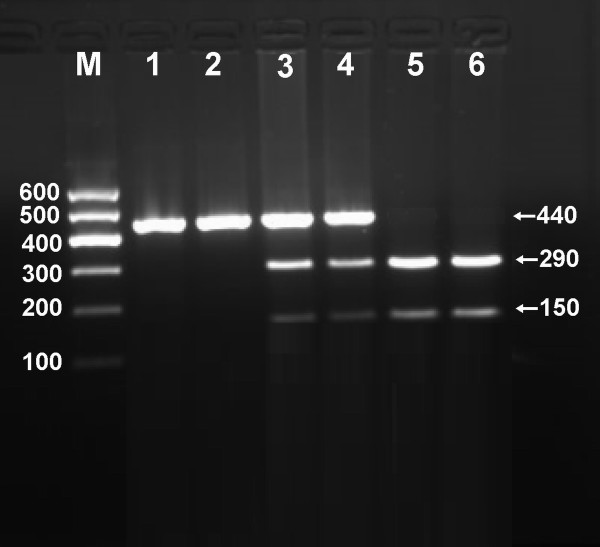
Genotyping of the PCSK9 E670G polymorphism. Lane M, 100 bp marker ladder; lanes 1 and 2, GG genotype (440 bp); lanes 3 and 4, AG genotype (440-, 290- and 150-bp); and lanes 5 and 6, AA genotype (290- and 150-bp).